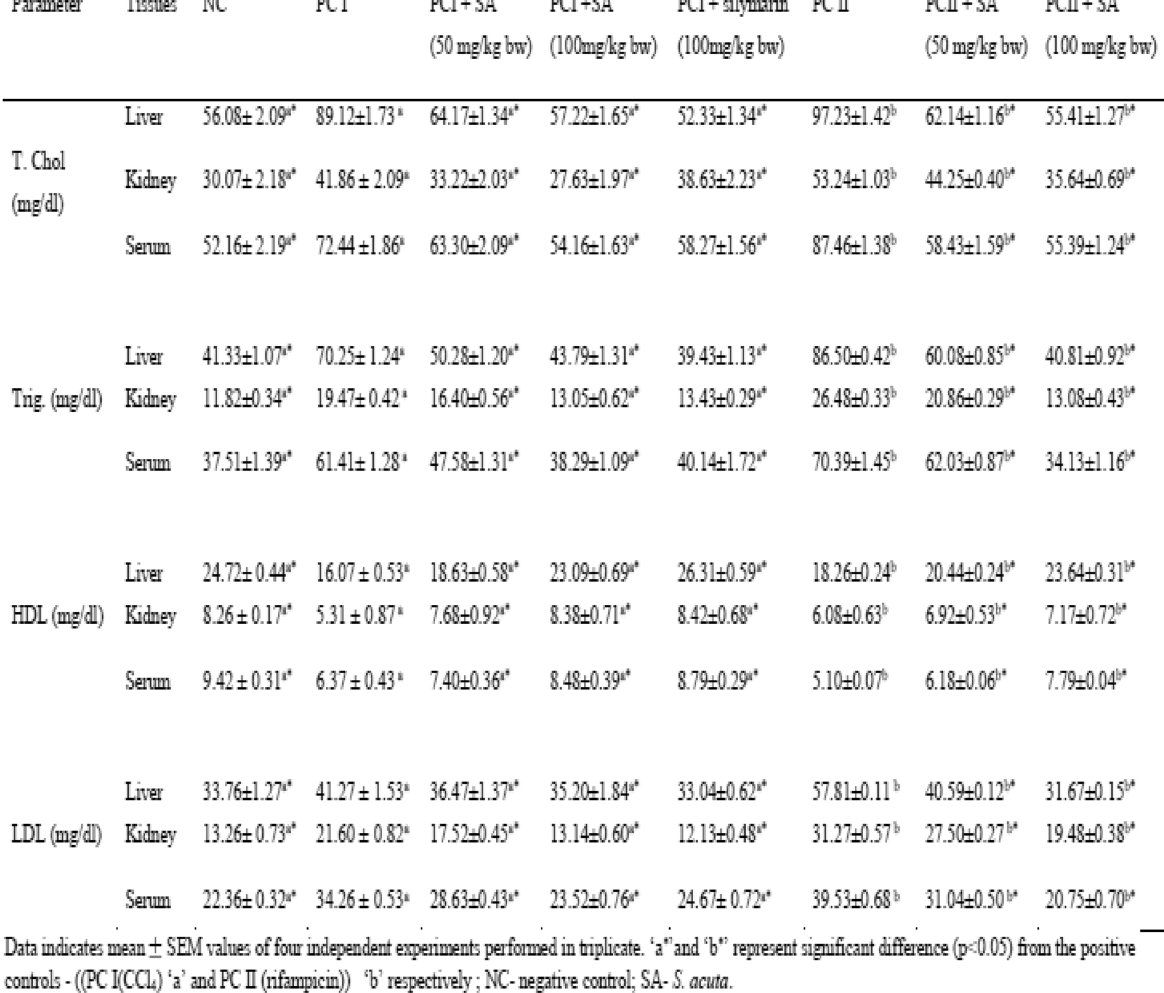
Data indicates mean ± SEM values of four independent experiments performed in triplicate. ‘ a* ’ and ‘ b* ’ represent significant difference ( p <0.05) from the positive controls – ((PC I(CCI4) ‘ a ’ and PC II (rifampicin)) ‘ b ’ respectively; NC- negative control; SA- S.